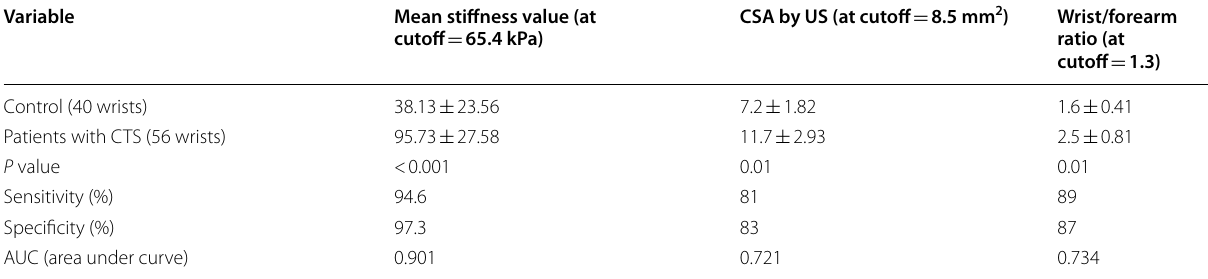
Table 2 Median nerve CSA, wrist-to-forearm ratio, and median nerve mean stiffness value by ultrasound elastography across controls and different CTS severity